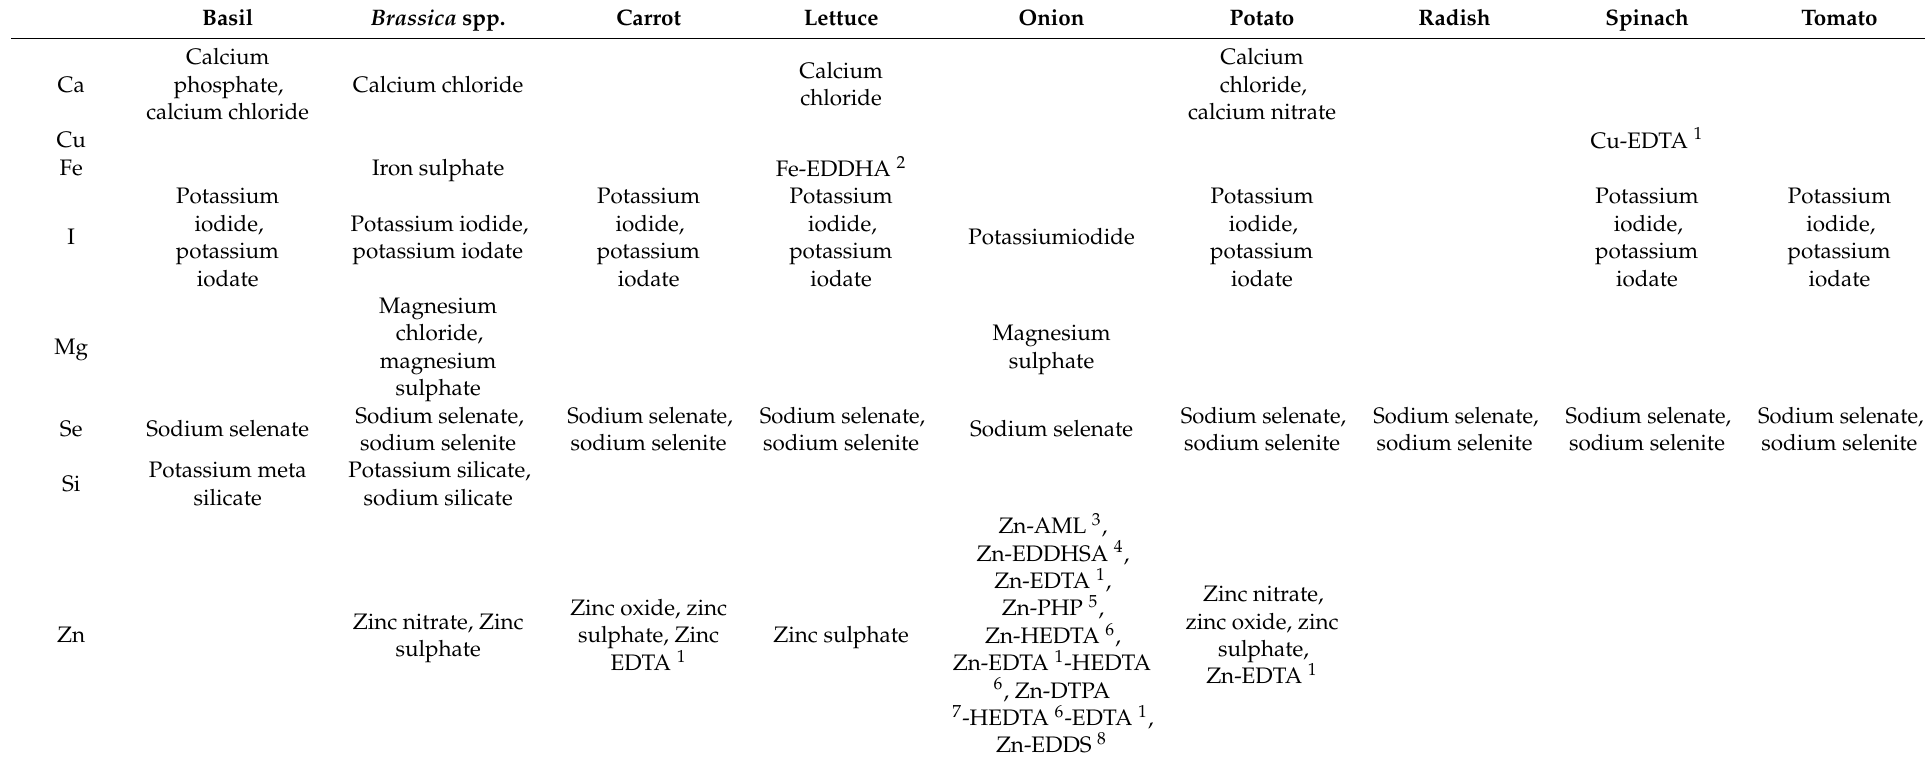
Table 2. Chemical forms of each mineral used in the biofortification of some vegetable